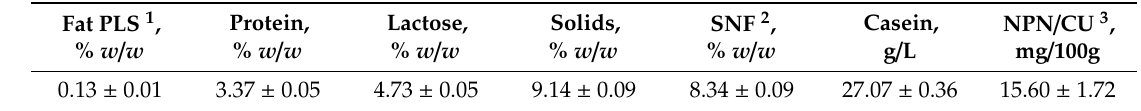
Table 1. Average composition of milk.